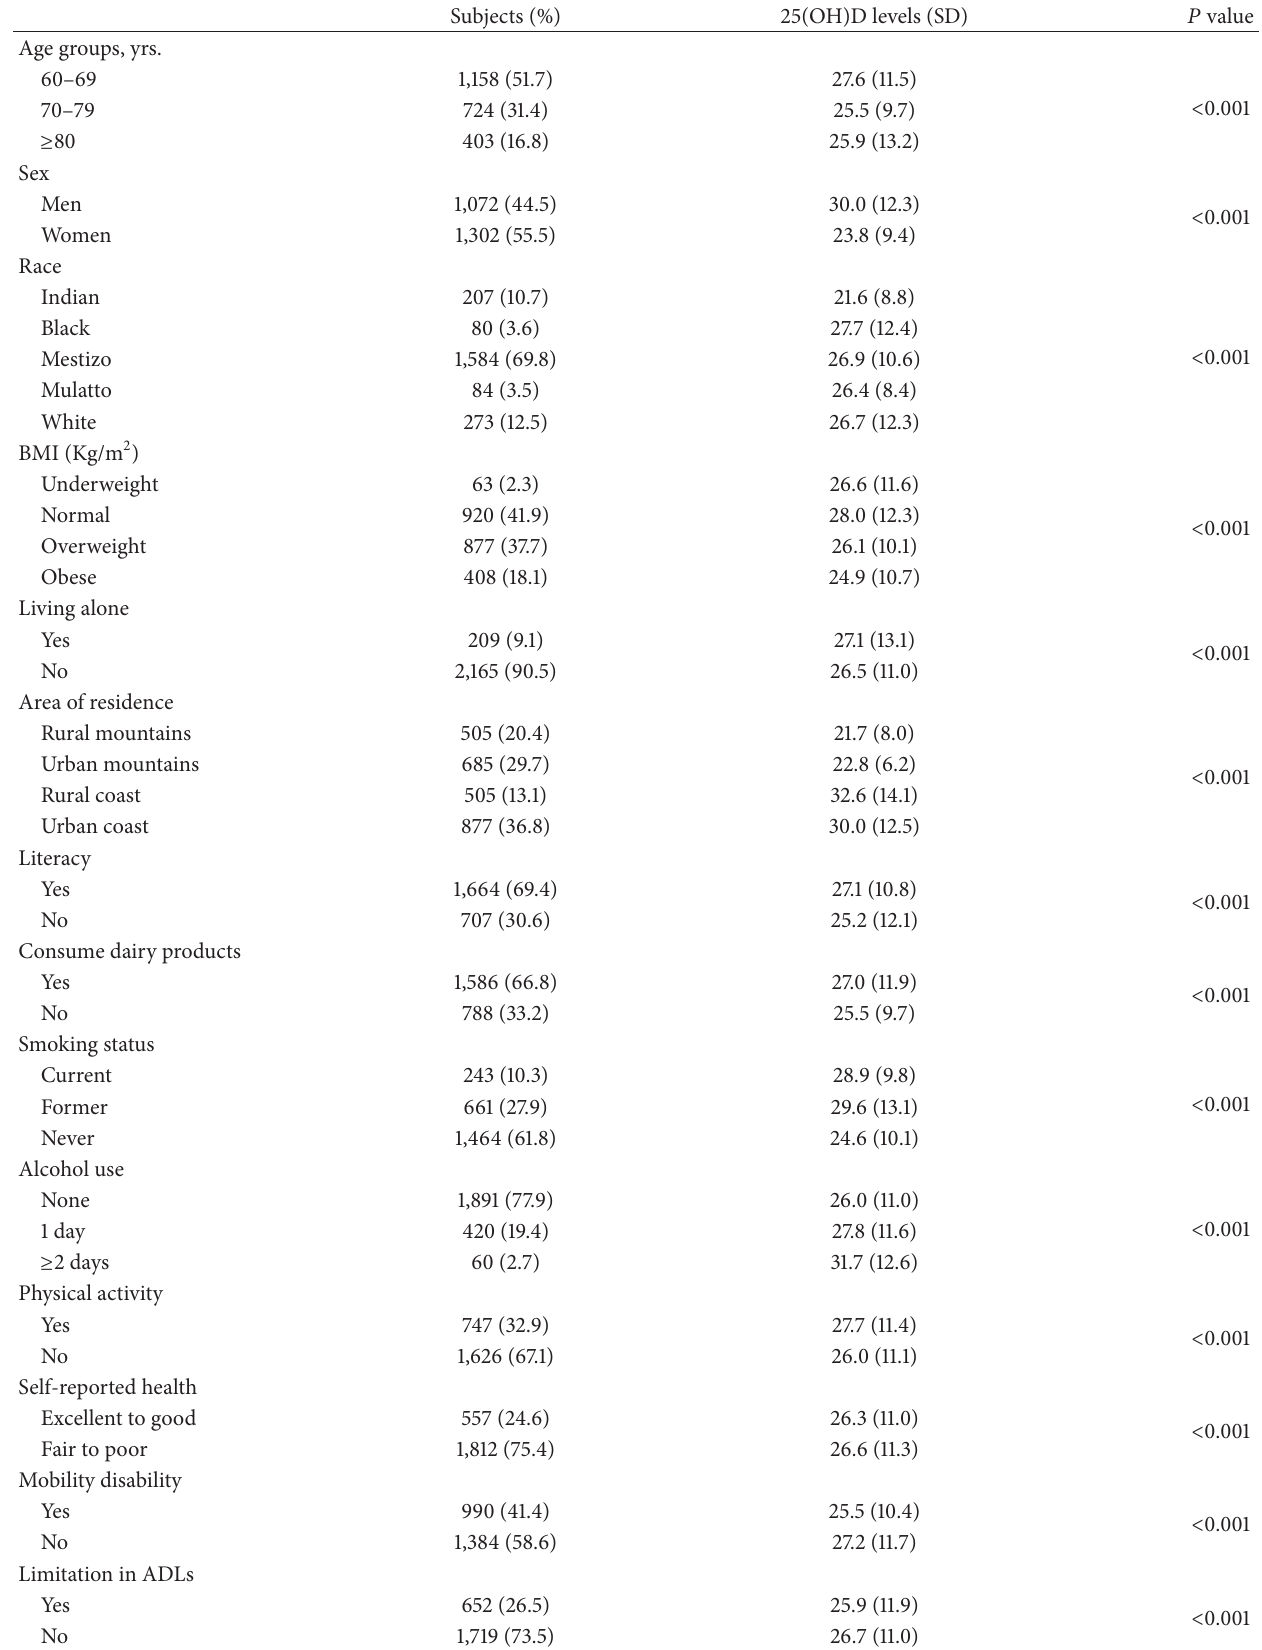
Table 1: 25(OH)D levels by selected characteristics among older adults in